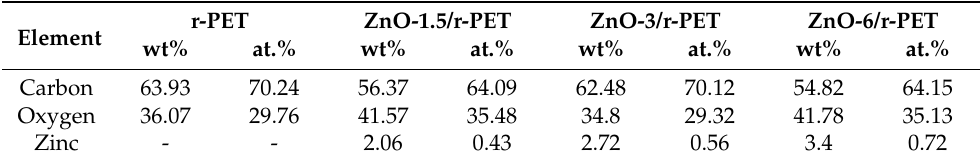
Table 1. EDS data analysis of r-PET composite